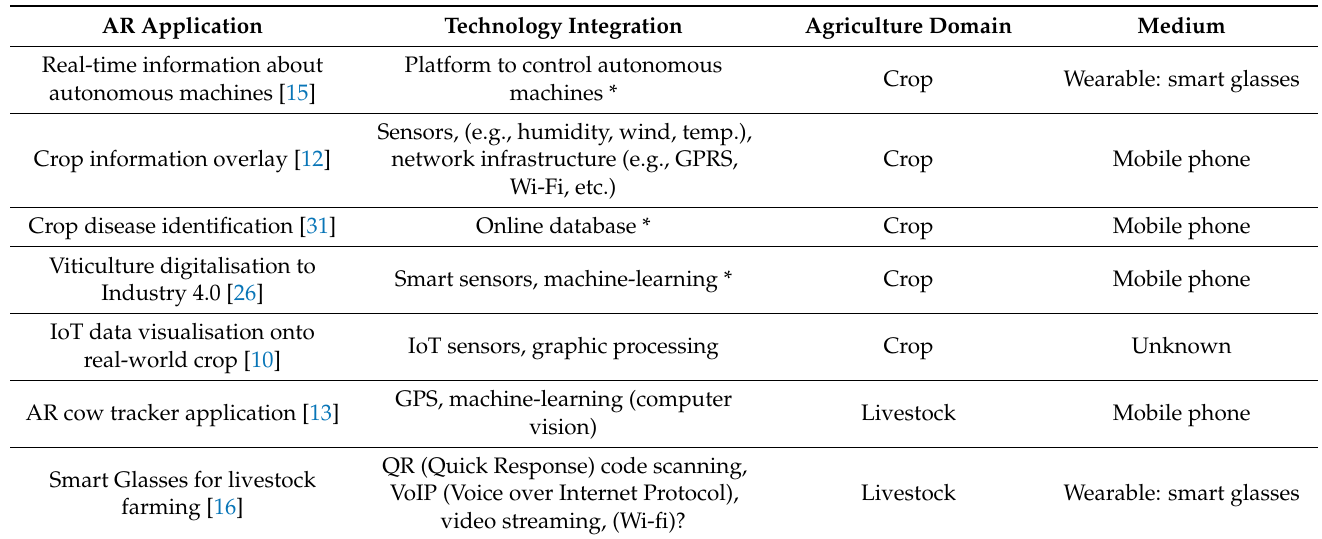
Table 1. AR Applications and Supporting